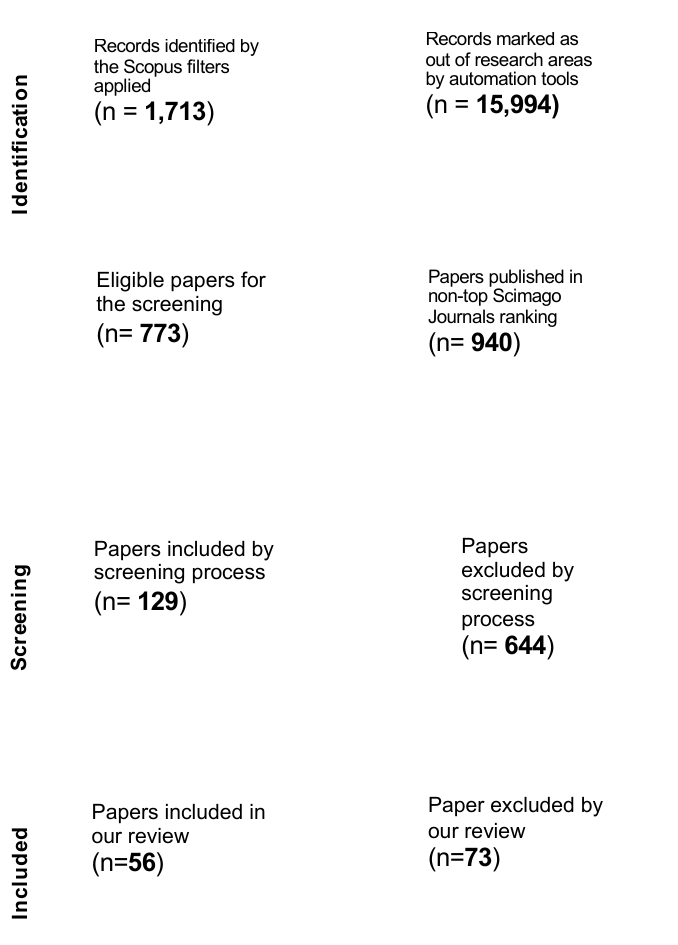
Table 2. Geographical areas and working condition dimensions studied in the papers. Legend: Ho_Fam (the unequal distribution of household management and childcare); Wom_Job (women’s job losses and income reductions); Mod_W (modality of working); W_H (working hours); MH (mental health).